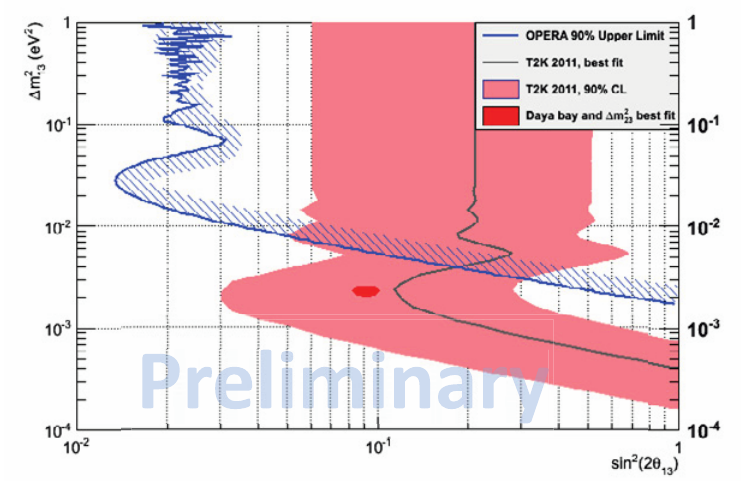
, sin 2 (2 θ 13 )) oscillation parameter 13